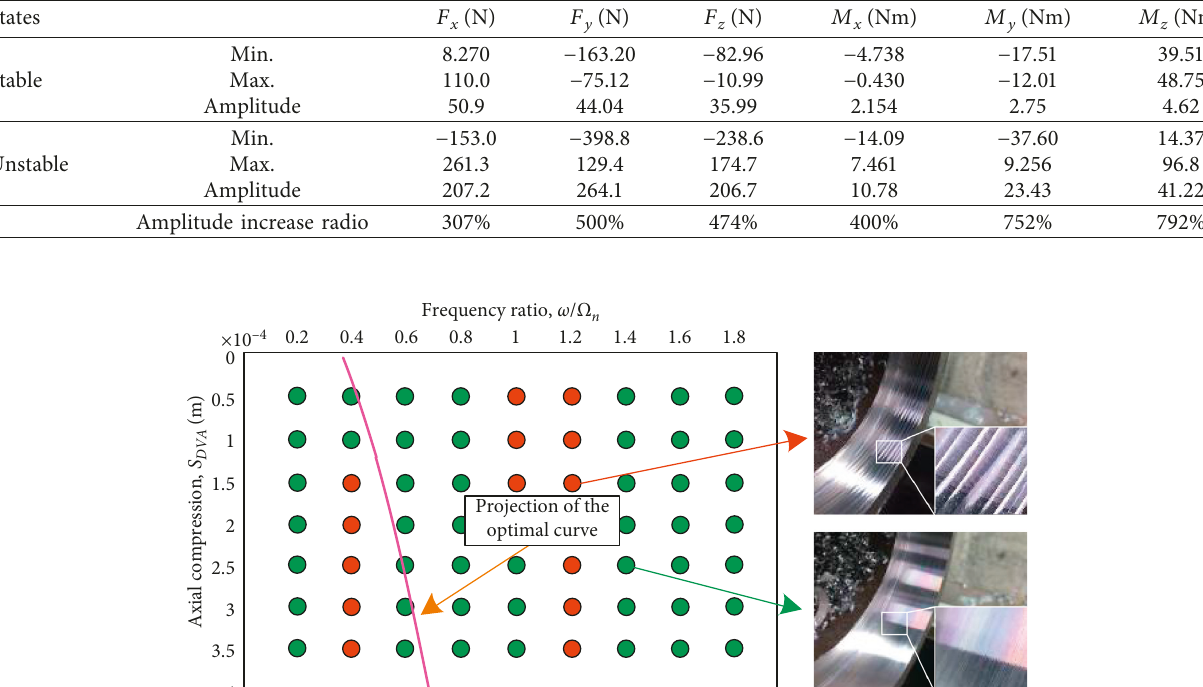
Figure 18: Unstable states. Table 3: Statistical results of the cutting force and moment of the stable and unstable